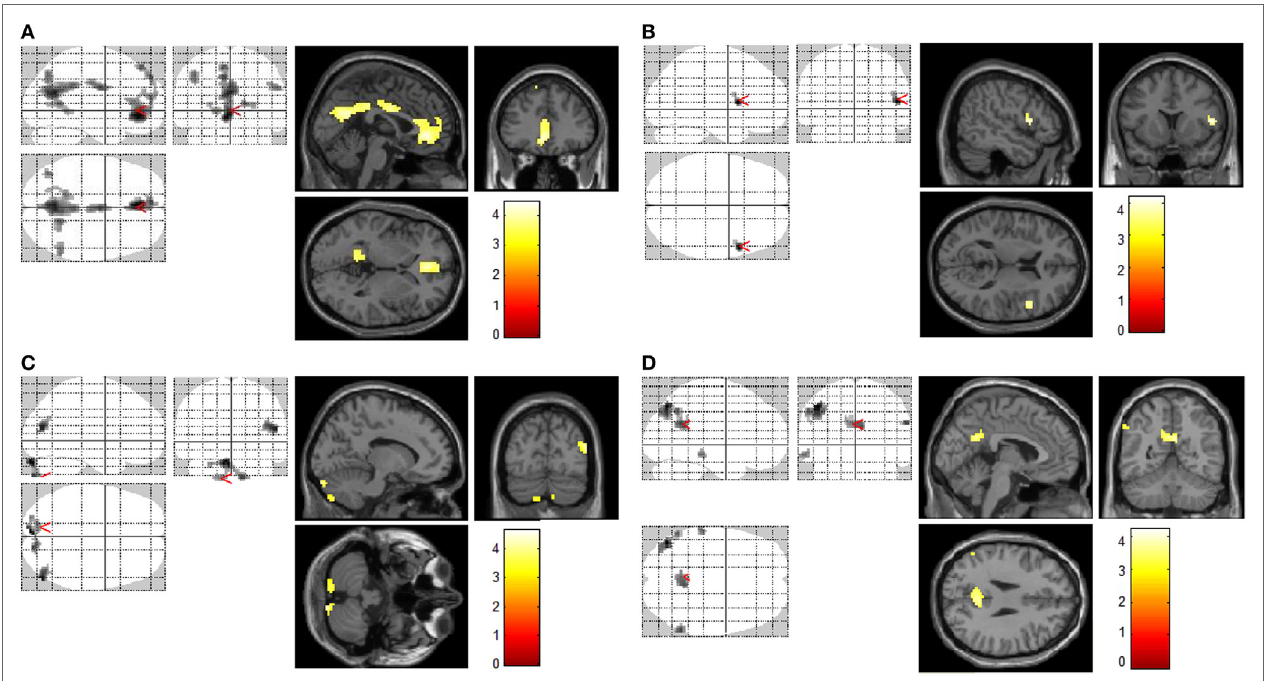
FigUre 1 | Increased brain regions of activation by different cues. Increased brain regions of activation in chronic ketamine users during exposure to ketamine use-related films when compared with control subjects [smokers and non-smokers (a) ]; increased brain regions of activation in chronic smokers (chronic ketamine users were also chronic smokers) during exposure to smoking-related films when compared with non-smokers (B) ; increased brain regions of activation in control subjects (smokers and non-smokers) during exposure to sexual films when compared with chronic ketamine users (c) ; in respects to ketamime cue minus smoking cue, increased brain regions of activation in chronic ketamine users when compared with chronic smokers (D) . AlphaSim corrected p <